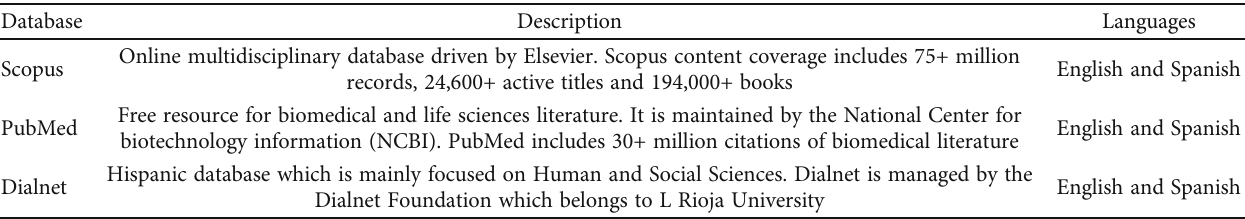
Table 2: Databases used for this